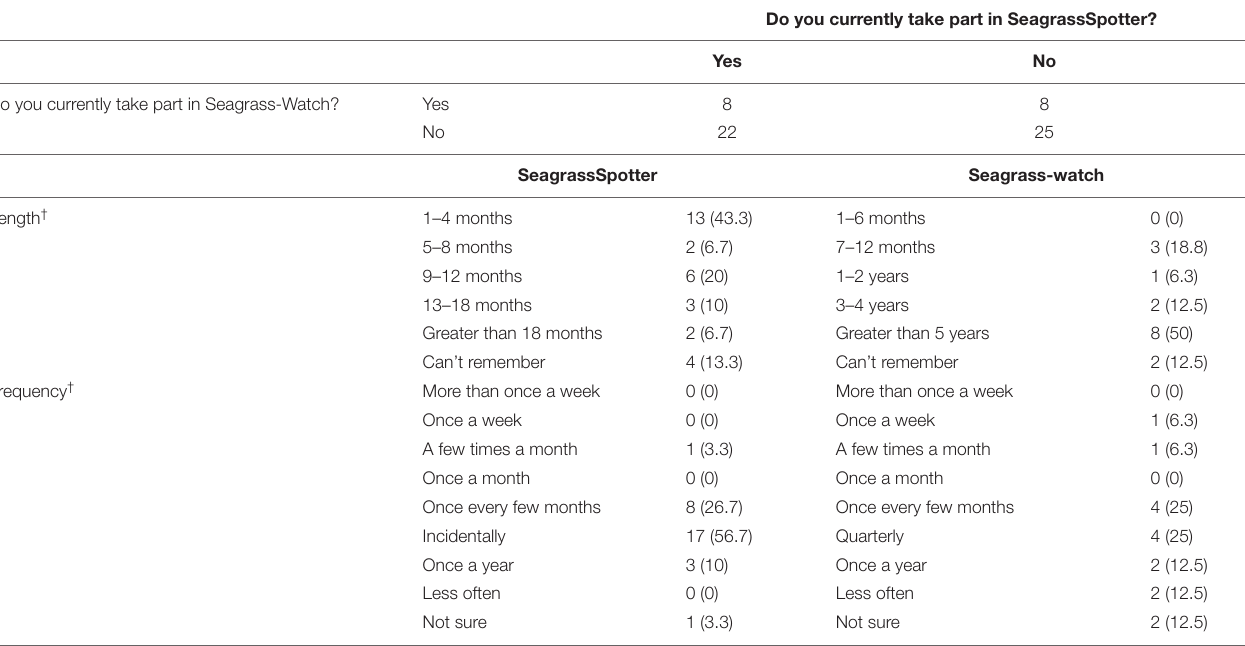
TABLE 4 | Variation in the number of participants, participation length and frequency of focal seagrass citizen science